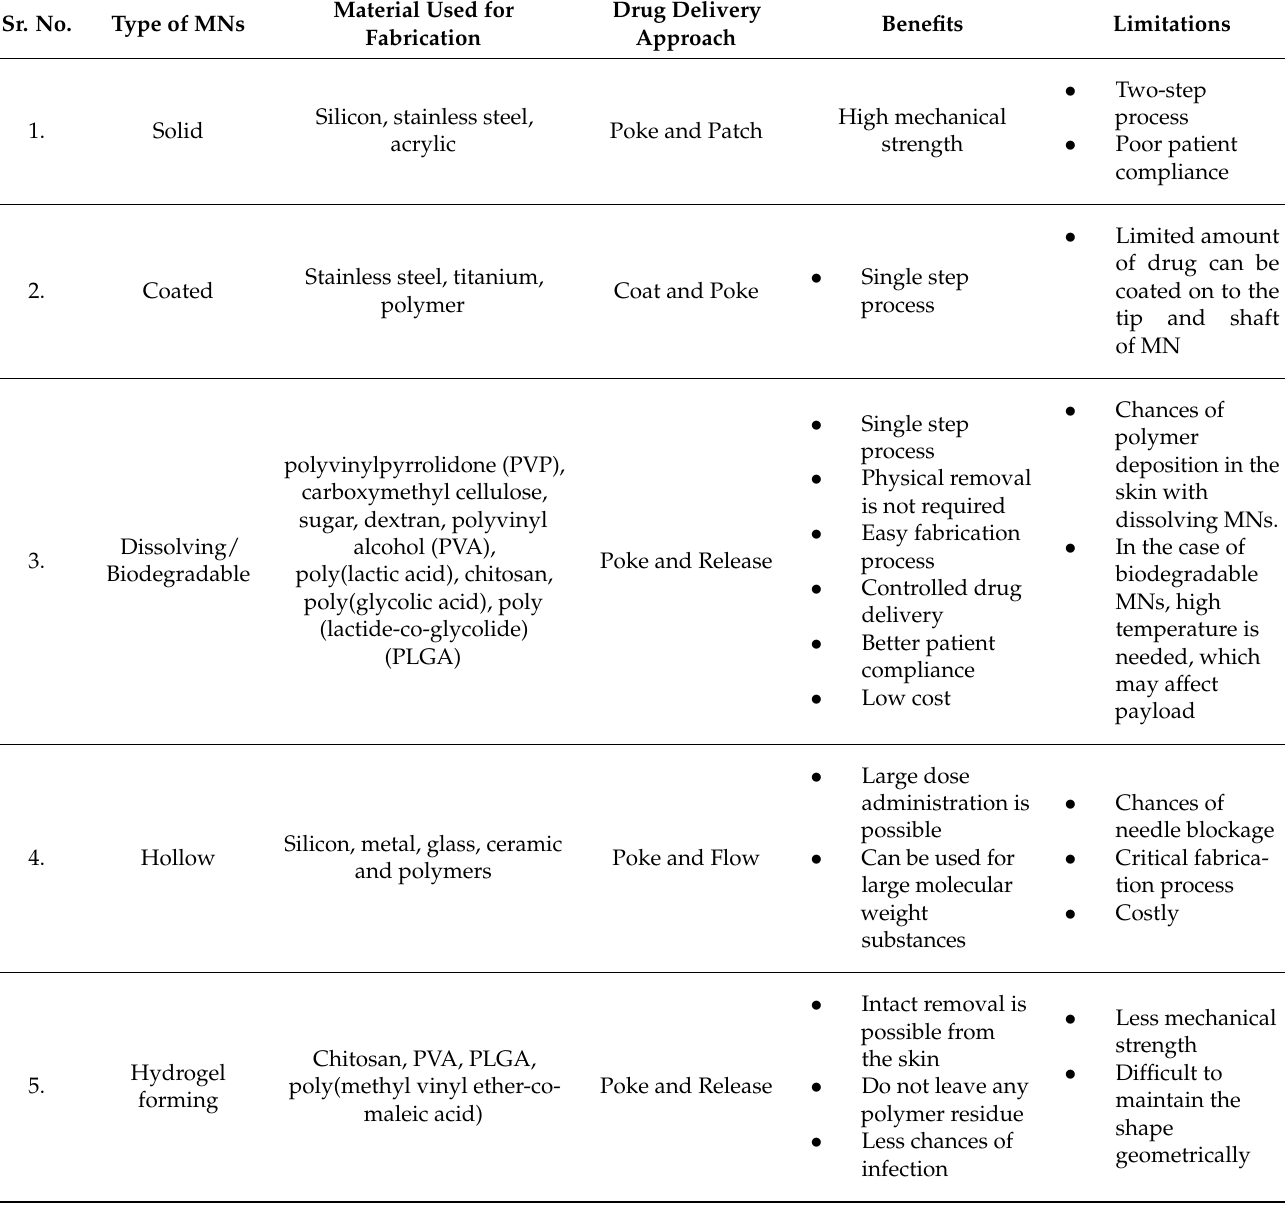
Table 1. Types of MNs [44]. (Adapted with permission from Ref. [44]. Copyright 2019